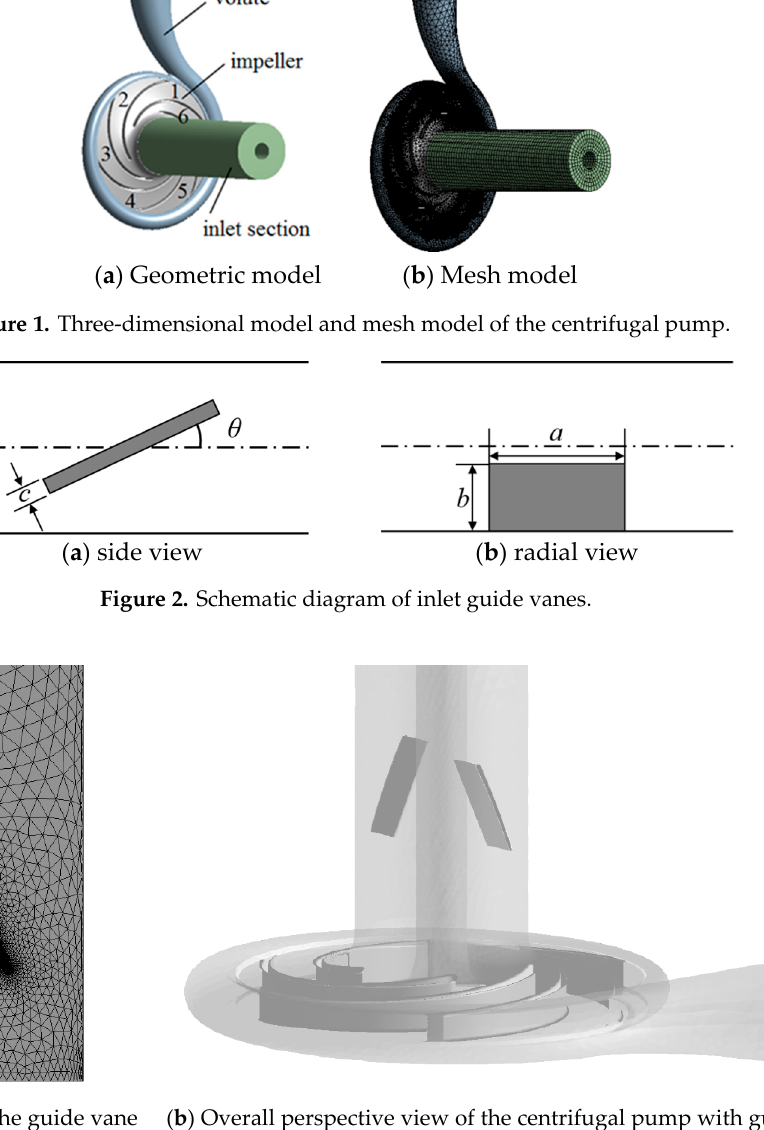
Figure 1. Three-dimensional model and mesh model of the centrifugal pump.